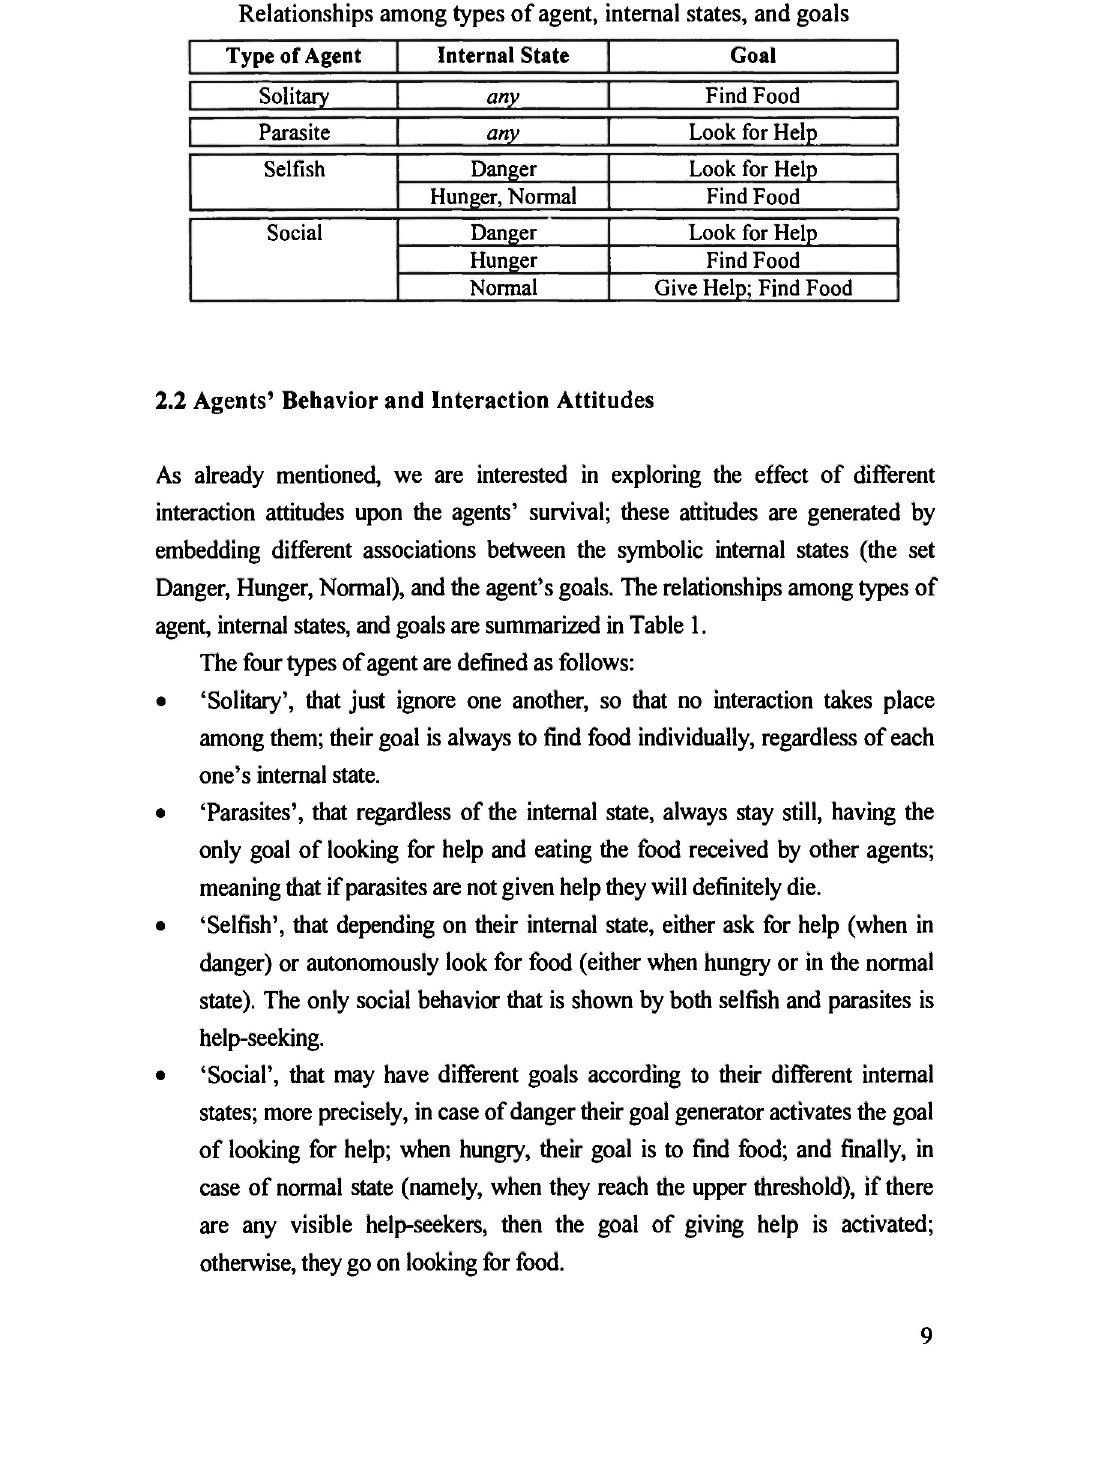
Relationships among types of agent, internal states, and